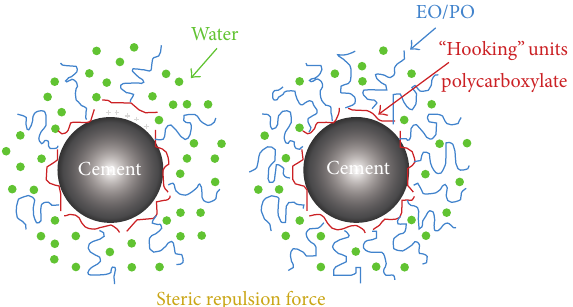
Figure 10: FE-SEM images of cement mortar containing 1.5 wt% GO at scales of 1.0 𝜇 m after 28 days curing, showing calcium silicate hydrates (C-S-H) gel in the form of a dense sponge matrix that gradually spread, merge, and adhere to GO, strengthening the cement and reducing its